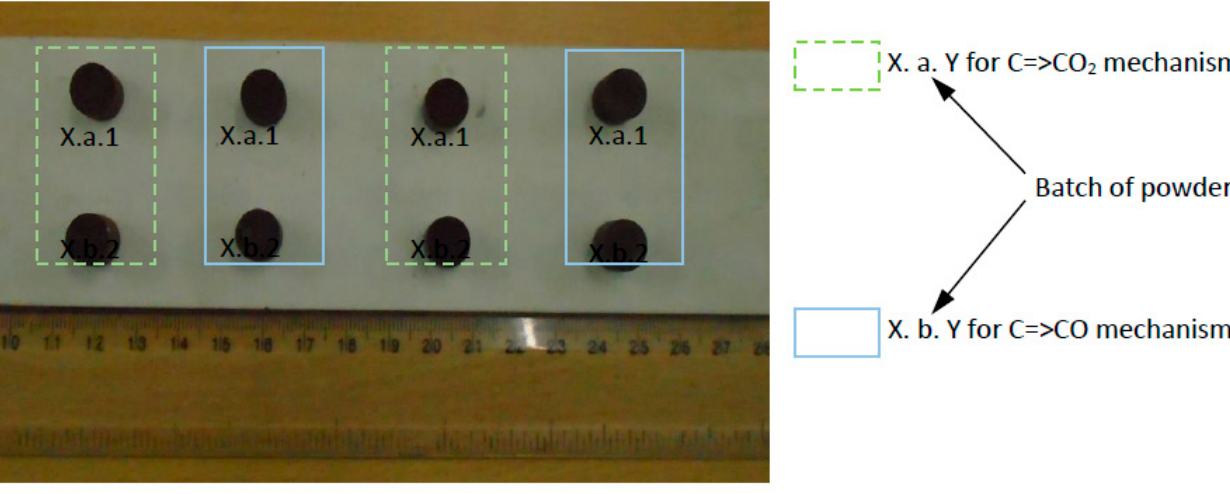
Figure 7. Sample position on an alumina plate while sintering.